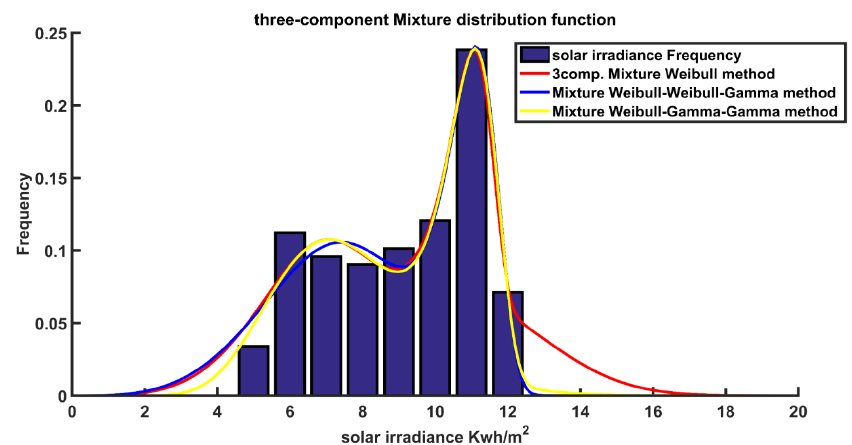
Figure 7. The three-component mixture distribution functions in the solar irradiance modeling.